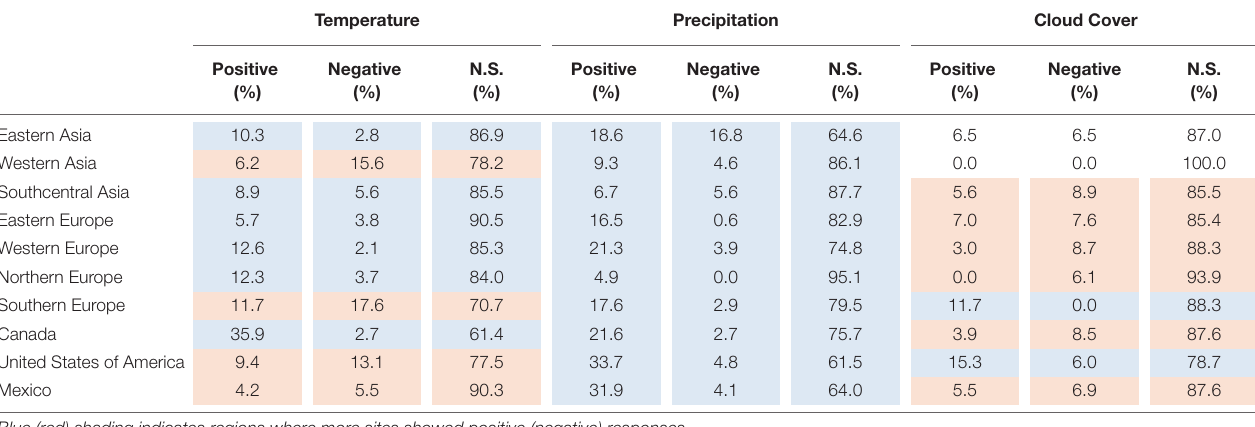
TABLE 2 | Percentage of RWI sites with significant positive or negative response function coefficients for each autumn climate variable (temperature, precipitation, and cloud cover) summarized by region.